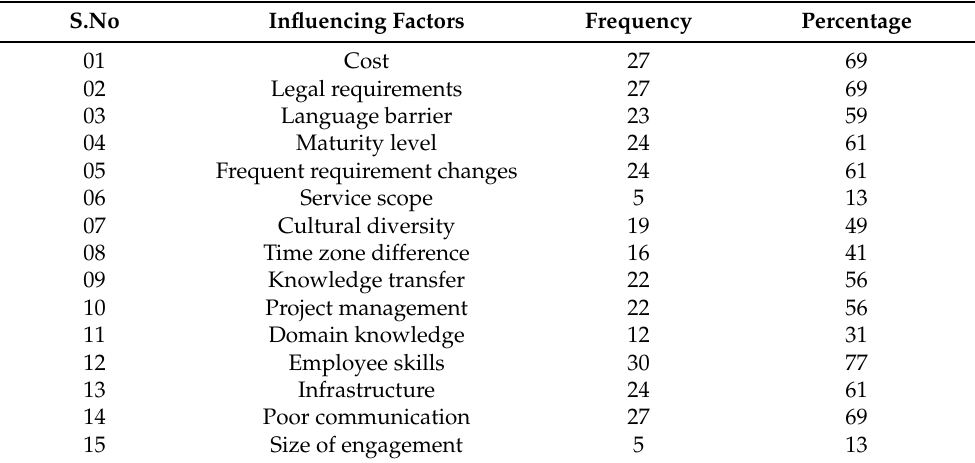
Table 3. Identified factors through the systematic literature review.